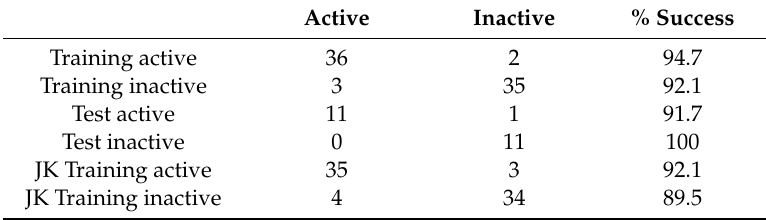
Table 3. Classification matrix for DF3.